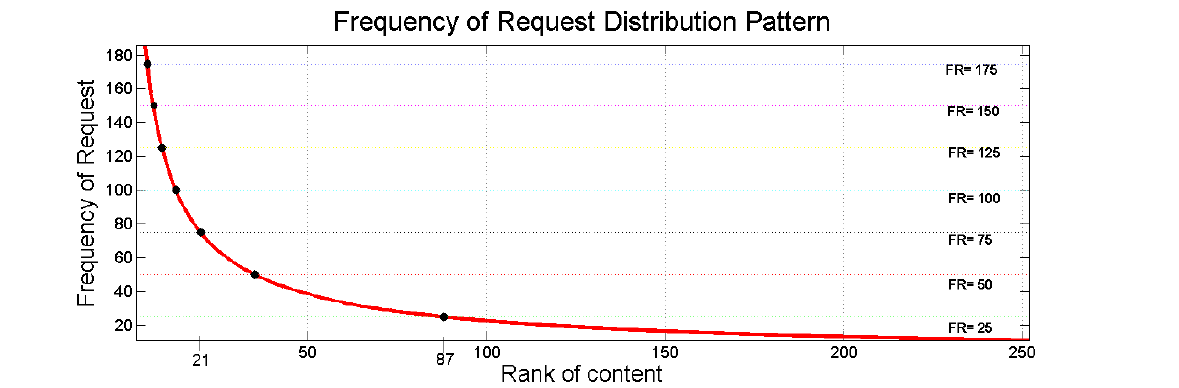
Figure 7. Number of top content for 1st class with various Frequency Limit